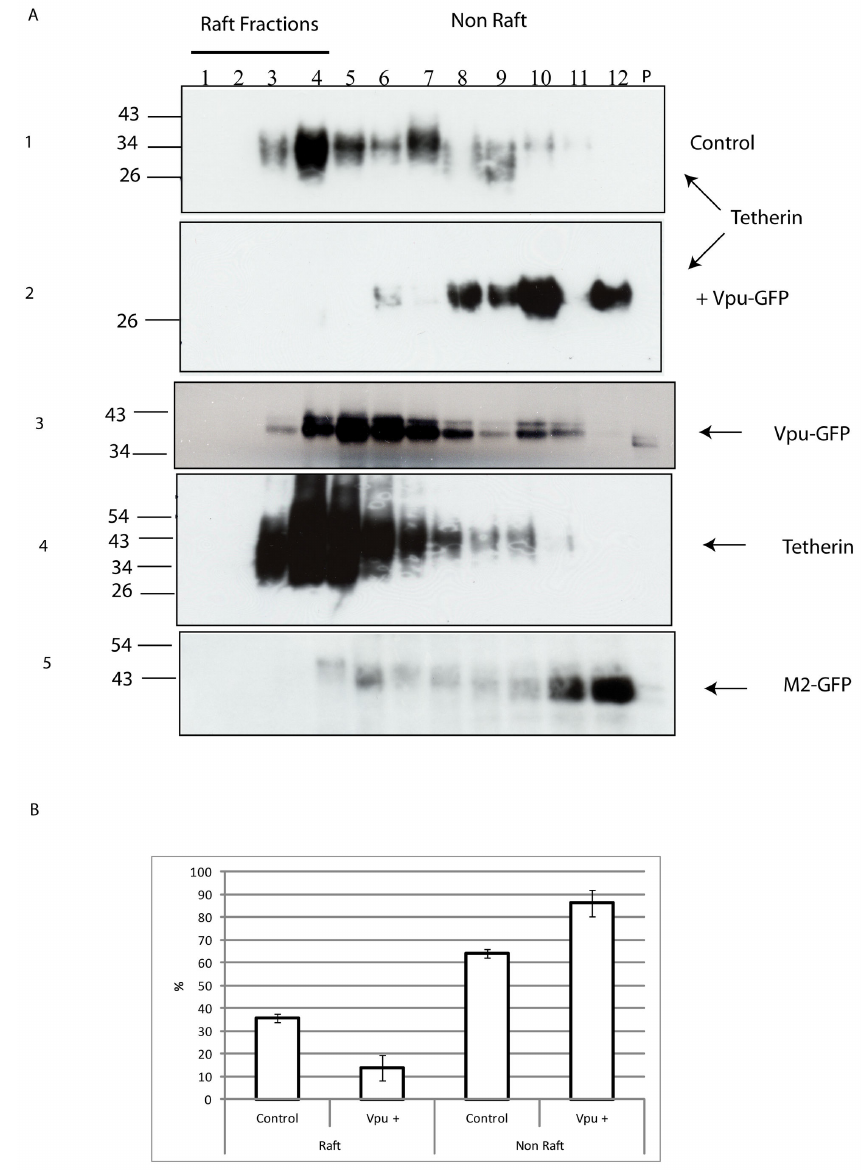
Figure 3. The effect of expression of Vpu on the lipid raft localisation of endogenous tetherin. A . HeLa cells were subjected to extraction in ice-cold Triton X-100 (1%) prior to separation by sucrose density gradient centrifugation, then analysis of fractions from the gradients by immunoblot. Fractions 1-4 are considered as lipid raft fractions, fractions 5-12 as non-raft fractions. The top panel shows an immunoblot, using an antibody to tetherin, of fractions from untransfected HeLa cells and confirms that a significant proportion of endogenous tetherin is present in lipid rafts (i.e. in fractions 1-4). The second panel shows an immunoblot, using an antibody to tetherin, of fractions from HeLa cells that had been transfected to express Vpu-GFP and shows that the majority of endogenous tetherin is lost from lipid rafts (i.e. fractions 1-4) in the presence of Vpu-GFP: this experiment was performed in the absence of lysosomal enzyme inhibitors, the blot was exposed longer to ensure detection of tetherin. Panel 3 shows the distribution of Vpu-GFP across the sucrose gradient; it has a broad distribution across the gradient, indicating that it is present in a range of membrane environments, both raft and non-raft. Expression of another viroporin protein (the M2 protein of influenza virus) does not lead to a redistribution of tetherin from lipid rafts, as shown by the bottom two panels. Panel 4 shows an immunoblot, using an antibody to tetherin, of fractions from HeLa cells that had been transfected to express M2-GFP and shows that the distribution of endogenous tetherin is similar to that in non-transfected cells (top panel). The bottom panel shows the distribution of M2-GFP across the sucrose gradient. B . Graphical representation of the proportions of tetherin molecules in raft vs. non-raft fractions on control HeLa cell and HeLa cells expressing Vpu-GFP (as indicated, n=5). doi: 10.1371/journal.pone.0075680.g003 PLOS ONE |